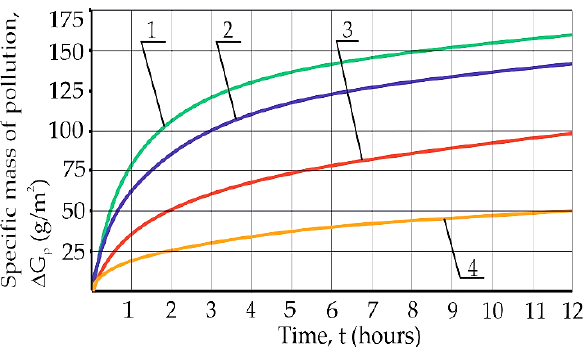
Figure 2. Dependences of pollution processes for the most characteristic modes: 1 — S r = 1.5%, α = 2.9, and W r = 2%; 2 — S r = 1.5%, α = 2.9, and W r = 17%; 3 — S r = 1.5%, α = 2.9, and W r = 30%; and 4 — S r = 1.5%, α = 2.9, and W r = 2% (DF).